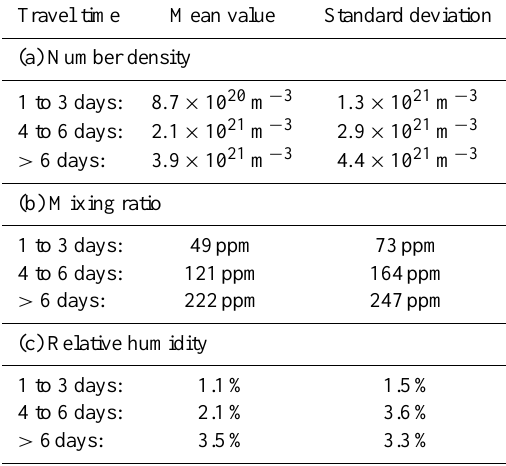
Table 2. Minimum humidity values in stratospheric intrusion layers as observed with the Zugspitze DIAL in the altitude range between 2.9 and 3.6km (in 2004 and from 2007 to June 2013) for different travel times from the stratosphere to Garmisch-Partenkirchen.